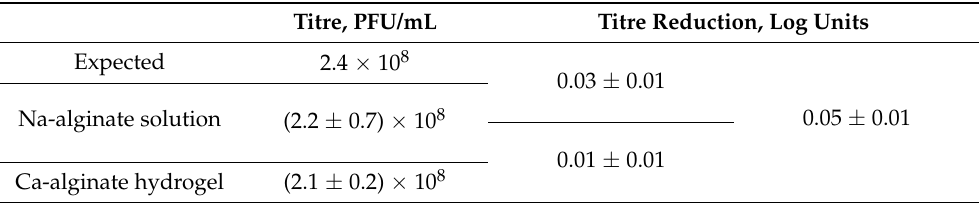
Table 3. Titre of the Pyo bacteriophages embedded in the Ca-alginate hydrogels. Titre,